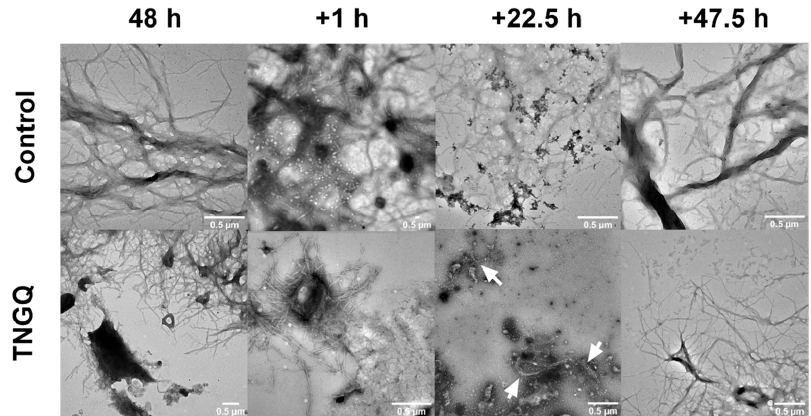
Figure 4. Transmission electron microscopy images of pre-formed IAPP fibrils in the absence (control) and presence of TNGQ at 48 h and additional 1, 22.5, and 47.5 h post-incubation. Scale bars represent 0.5 μ m. Arrows indicate presence of fibrils amongst amorphous aggregates.